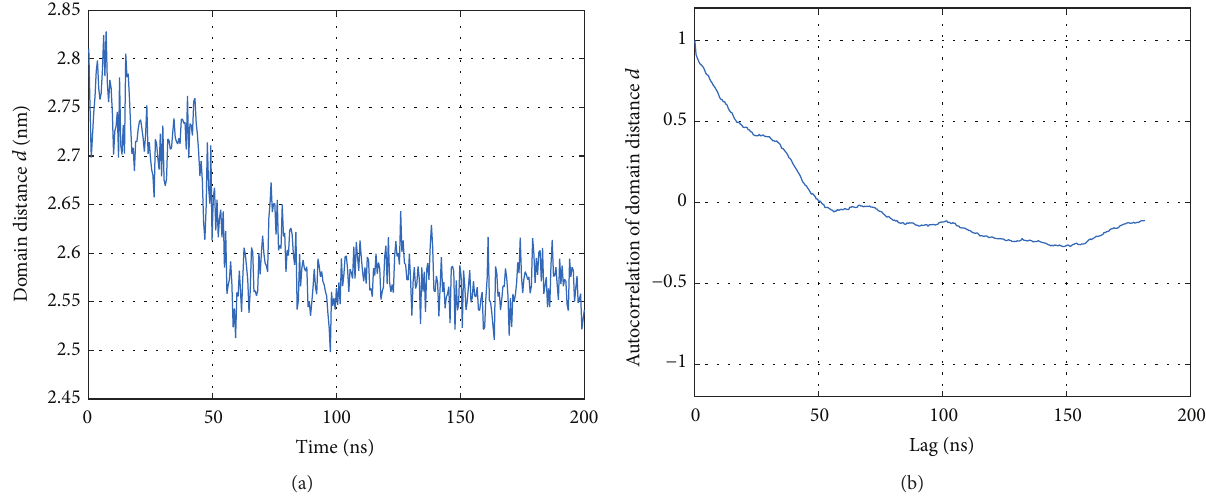
Figure 4: Distance between CD8 and MHC 𝛼 3 . (a) Distances computed according to (2). (b) Autocorrelation of distance values.